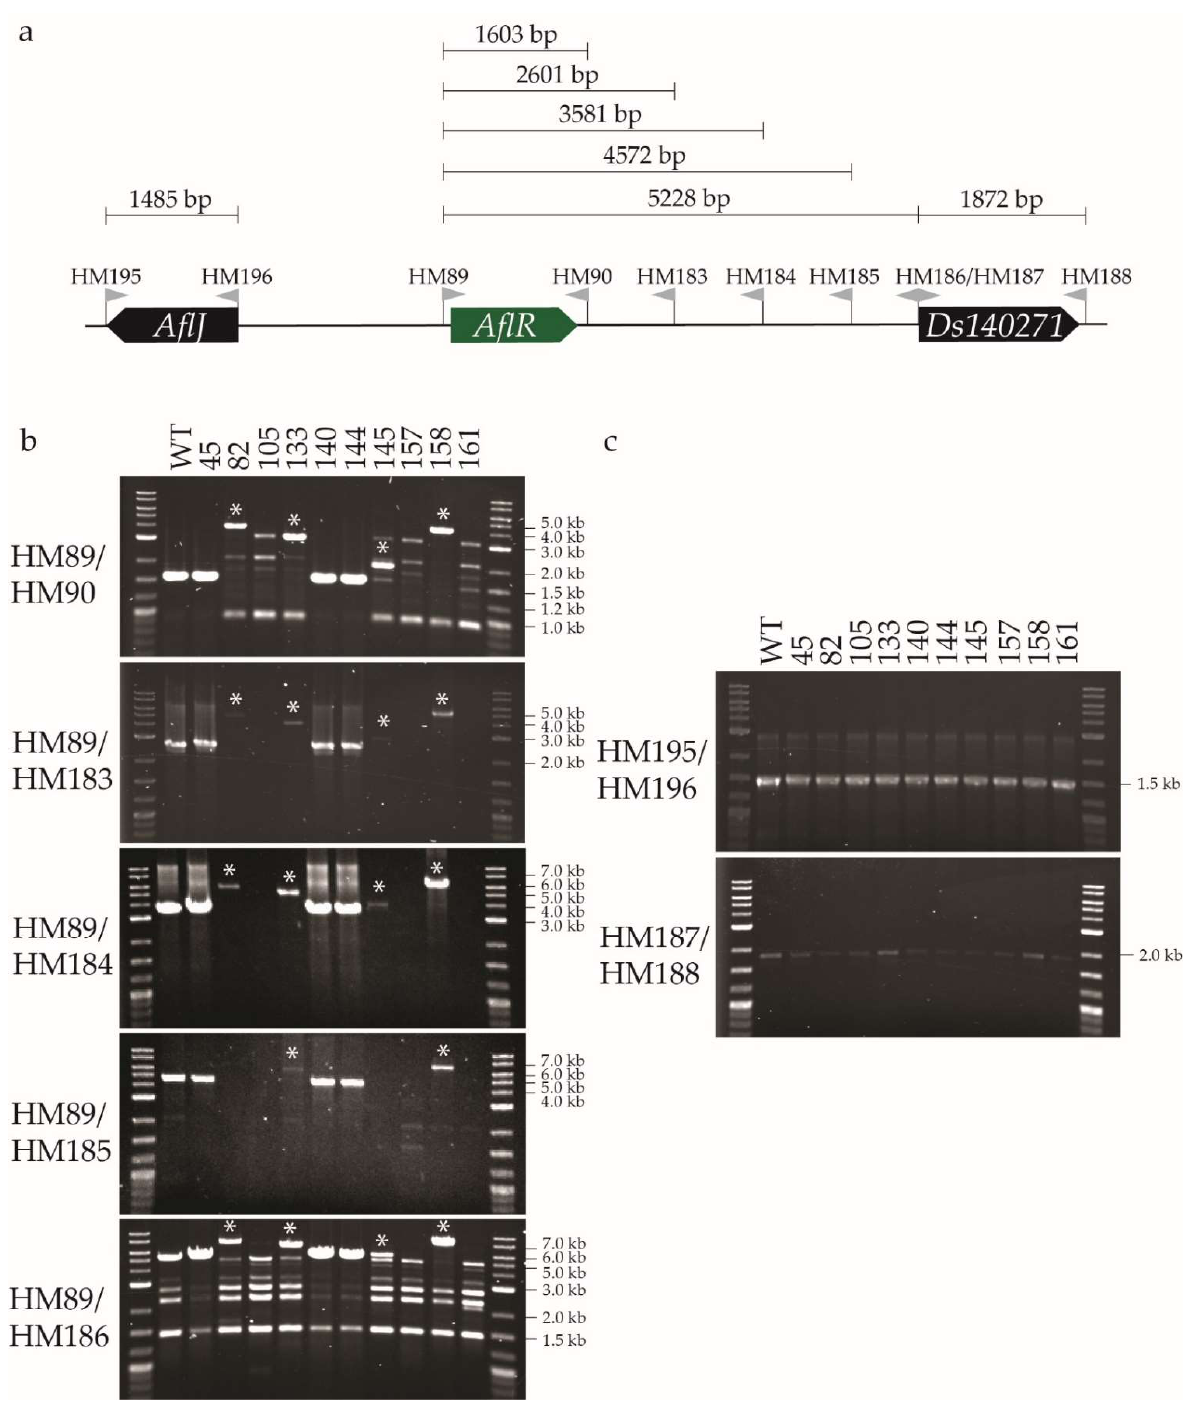
Figure 2. PCR screening to characterise Dothistroma septosporum AflR CRISPR/Cas9 transformants. ( a ) Primers used to screen the AflR region. Green bar is AflR, and black bars are flanking genes, labelled with either name or JGI protein ID. Positions of primers are illustrated by grey flags with the primer name above. Distances between the primer pairs shown above the primers. ( b ) PCR screen of AflR gene and intergenic region between AflR and Ds140271 . ( c ) PCR screen of genes upstream and downstream of AflR . Name of each transformant screened shown at the top of each group of gel pictures. PCR products larger than wild-type (WT)-sized PCR products labelled with a white asterisk. Relevant labels of the DNA ladder shown to the right of each gel picture, and primers used in each PCR shown on the left.